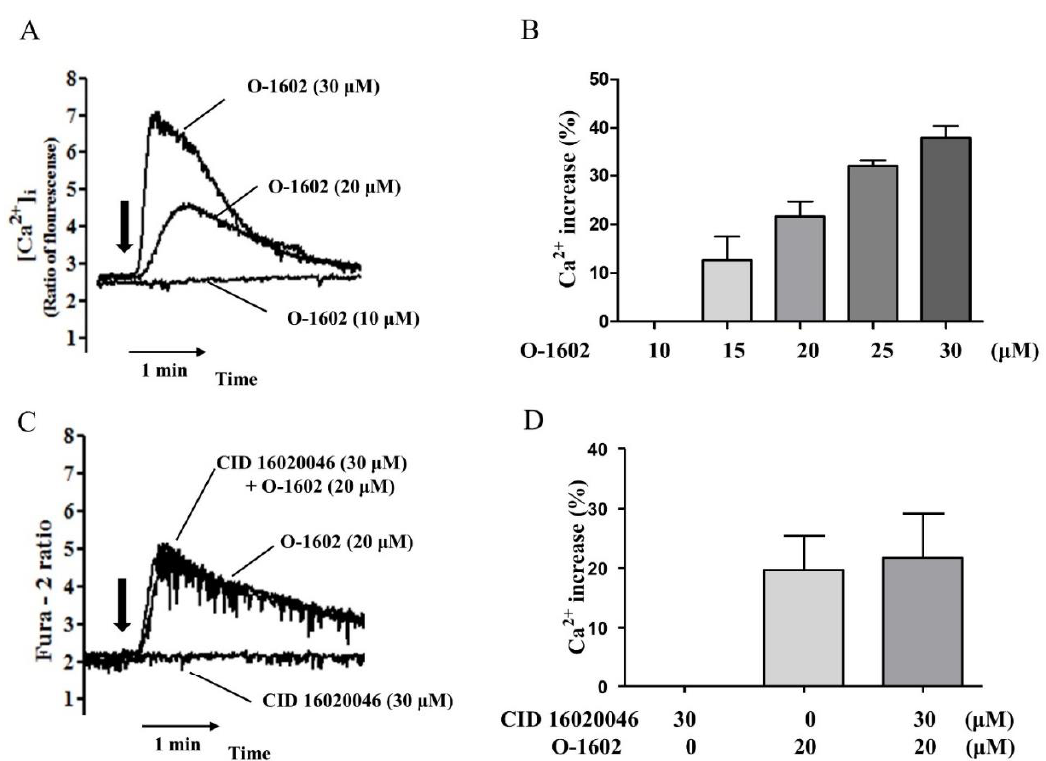
Figure 3. O-1602 induces intracellular Ca 2+ rise in Hep3B cells. ( A ) Representative Ca 2+ traces with 10 µ M, 20 µ M, and 30 µ M of O-1602. O-1602 was added at the time point indicated by the arrow. ( B ) Quantitated histogram of O-1602-induced Ca 2+ increase in Hep3B cells. ( C ) Representative Ca 2+ traces with 20 µ M of O-1602, 30 µ M of CID16020046, or both. ( D ) Quantitated histogram of O-1602 and CID16020046-induced Ca 2+ rise in Hep3B cells. Data are from three individual experiments and expressed as mean ± SD. The maximum Ca 2+ increase by each treatment was converted to a percentage of the digitonin-mobilized Ca 2+ increase.